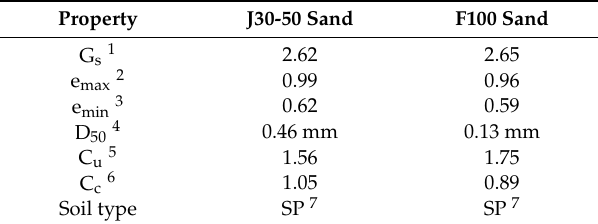
Table 1. Index properties of the